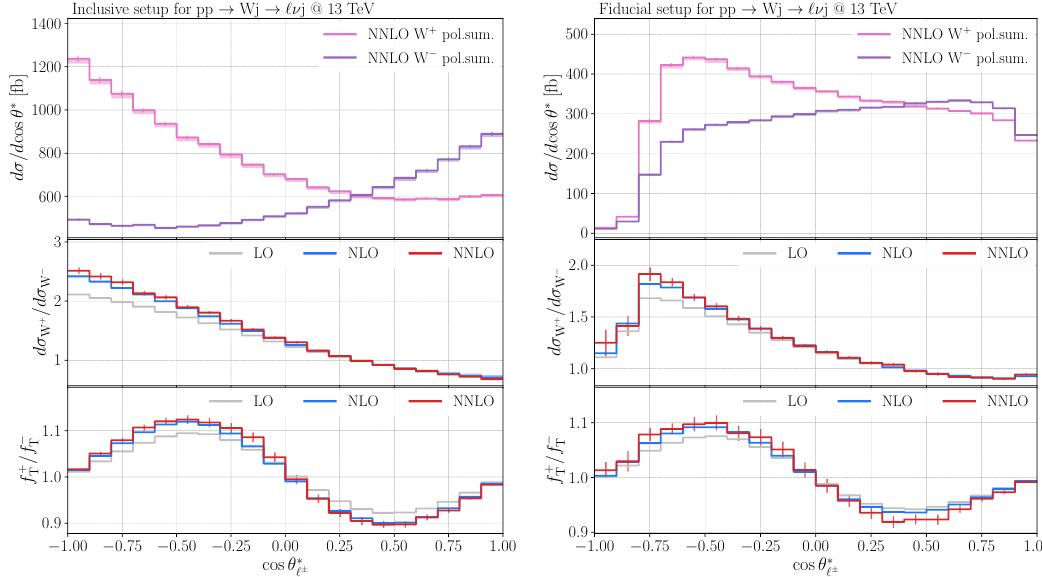
for pp → ‘ ± ( − ) ν j in the inclusive (left) and fiducial Figure 9 . Differential distributions of cos θ ∗ ‘ ‘ ± (right) setup. In the upper pane, the sum of the transversely and longitudinally polarised predictions for both signatures are displayed at NNLO QCD accuracy. In the middle pane, the ratio of the two signatures is shown at LO, NLO, and NNLO. The lower pane presents the ratio of the differential distributions of transverse polarisation fractions between the two signatures, also at LO, NLO, and NNLO. In the upper plot, the bands represent the 7-point scale variation, while the bars indicate the Monte Carlo uncertainty for in all three